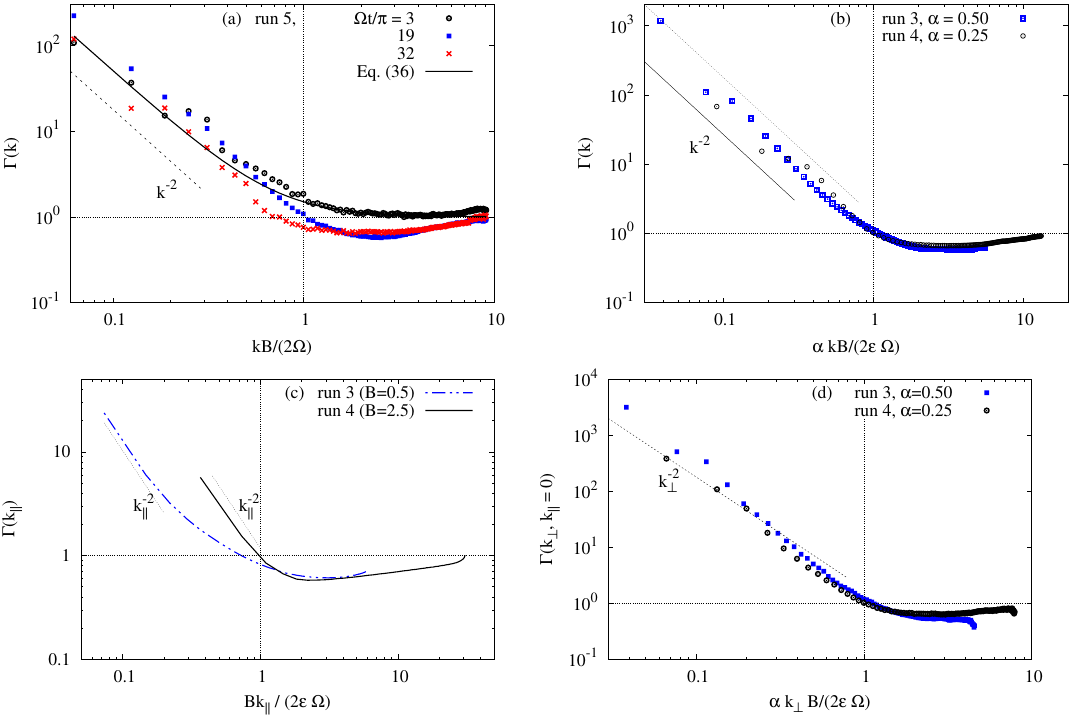
Figure 12. Alfvén ratio between kinetic and magnetic energies versus local Lehnert’s number. ( a ) Γ ( k , t ) = E ( κ ) ( k , t ) / E ( m ) ( k , t ) versus L Ω = Bk / ( 2 Ω ) at the dimensionless time Ω t / π = 3, 19,